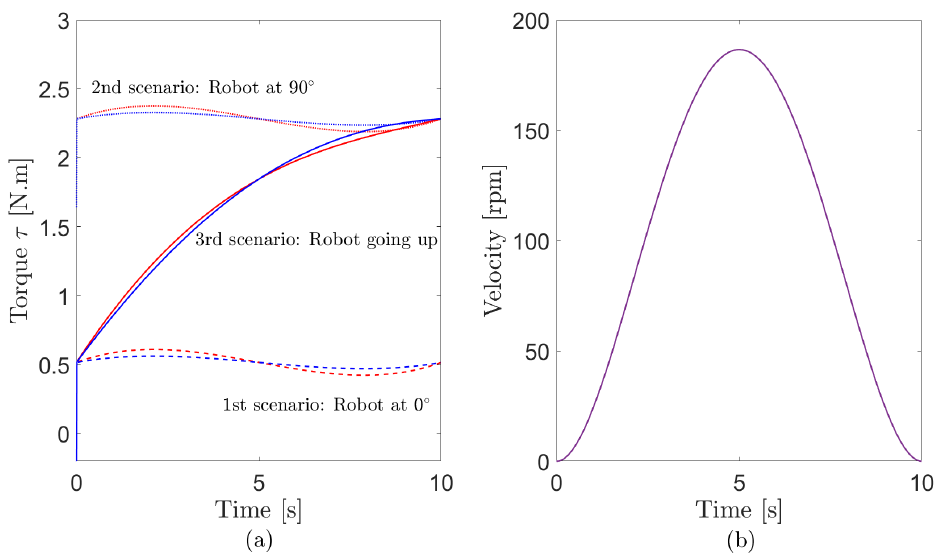
Figure 5. Simulation results of Kinematic and Dynamic models: right wheel torque (red) and left wheel torque (blue): red( a ) Torque output in simulation. ( b ) Velocity profile in